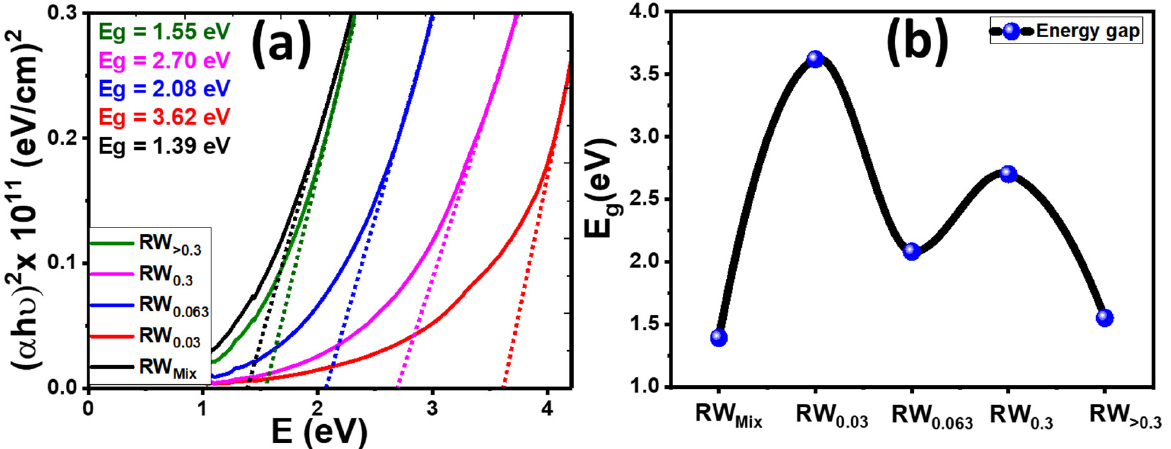
Figure 6. ( a ) ( α h ν ) 2 versus h ν and ( b ) variation of E g for all RW samples. The obtained Eg values are plotted in Figure 6b for all RW samples and listed in Table 1. The estimated energy band gap of the RW Mix , RW 0.03 , RW 0.063 , RW 0.3 and RW >0.3 nanopowders are 1.39, 3.62, 2.08, 2.7 and 1.55 eV, respectively. The Eg of nanostructured RW is blue-shifted from 3.62 to 1.55 eV as the particle size of natural RW increased from RW 0.03 to RW >0.3 . The blue shift may be related to the development of a resonance structure (state) in the density of states and the split-off band by introducing deep states into the bandgap [79]. From Figures 1B, 4c and 6b, the RW >0.3 nanopowder is the most